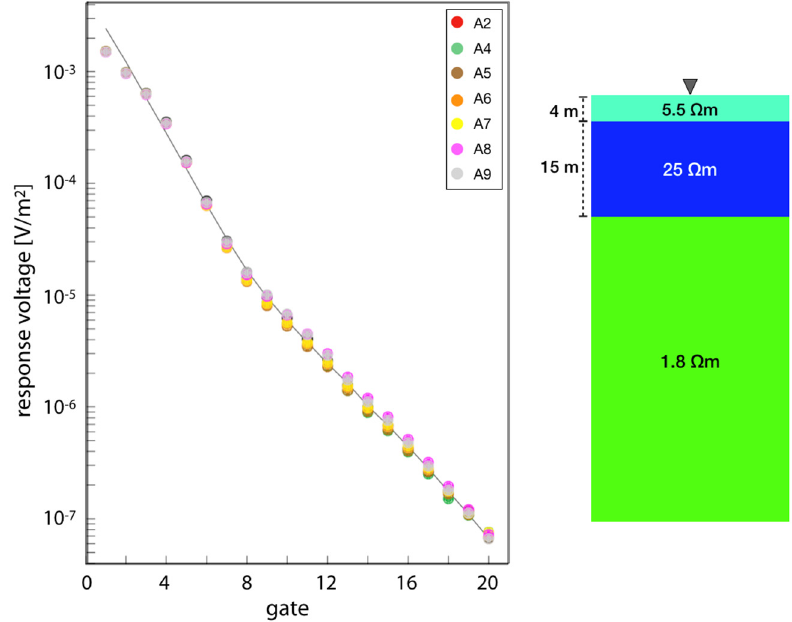
Figure 6. ( left ) 1D analytic forward result for station A2, A4 to A9 shown as the black solid line; ( right ) The resistivity model corresponds to the response (sold line) displayed in the left panel.